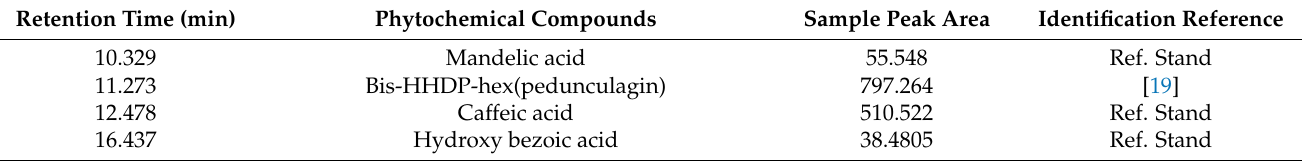
Figure 2. HPLC-UV chromatogram of the crude extract of Indigofera linifolia recorded at 320 nm. Table 2. Identified phytochemicals in the crude extract of Indigofera linifolia (identified from HPLC- UV